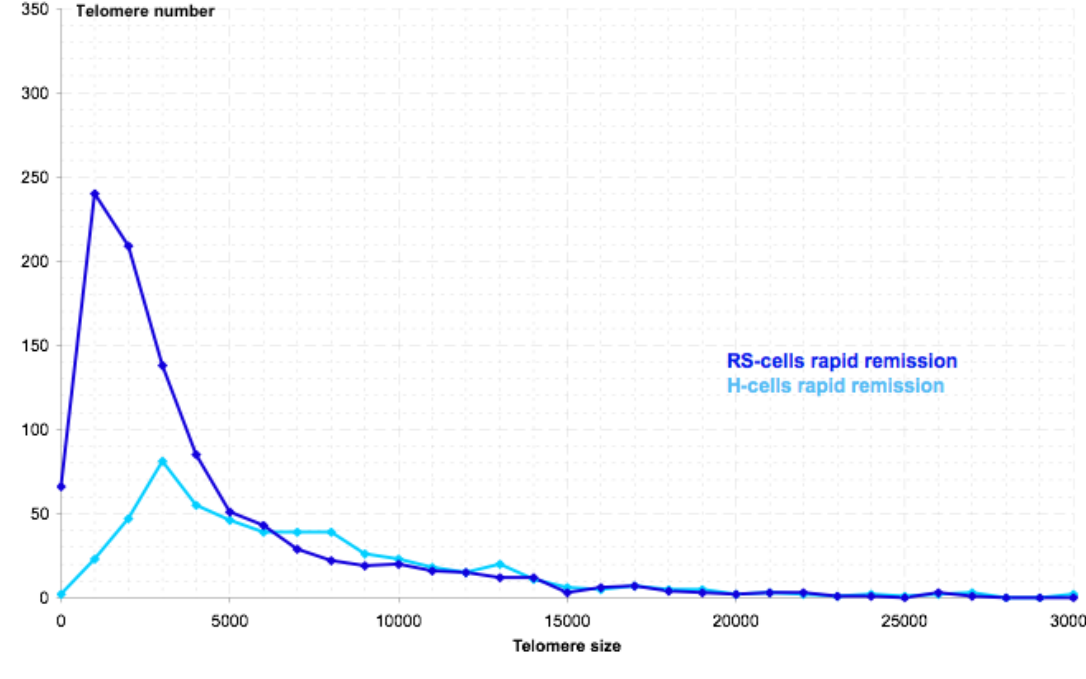
Figure 4. Typical telomere profiles at first diagnostic biopsy associated with rapid remission (top) and relapsing/refractory disease (bottom). Telomere distribution according to size in mononuclear H-cells and bi/multinuclear RS-cells. Results are based on 3D analysis of 30 Hodgkin and 30 Reed-Sternberg cells in a 5 μm lymph node section of the diagnostic biopsy. Frequency (y-axis) and relative fluorescent intensity, i.e. , size of telomeres (x-axis), are plotted against each